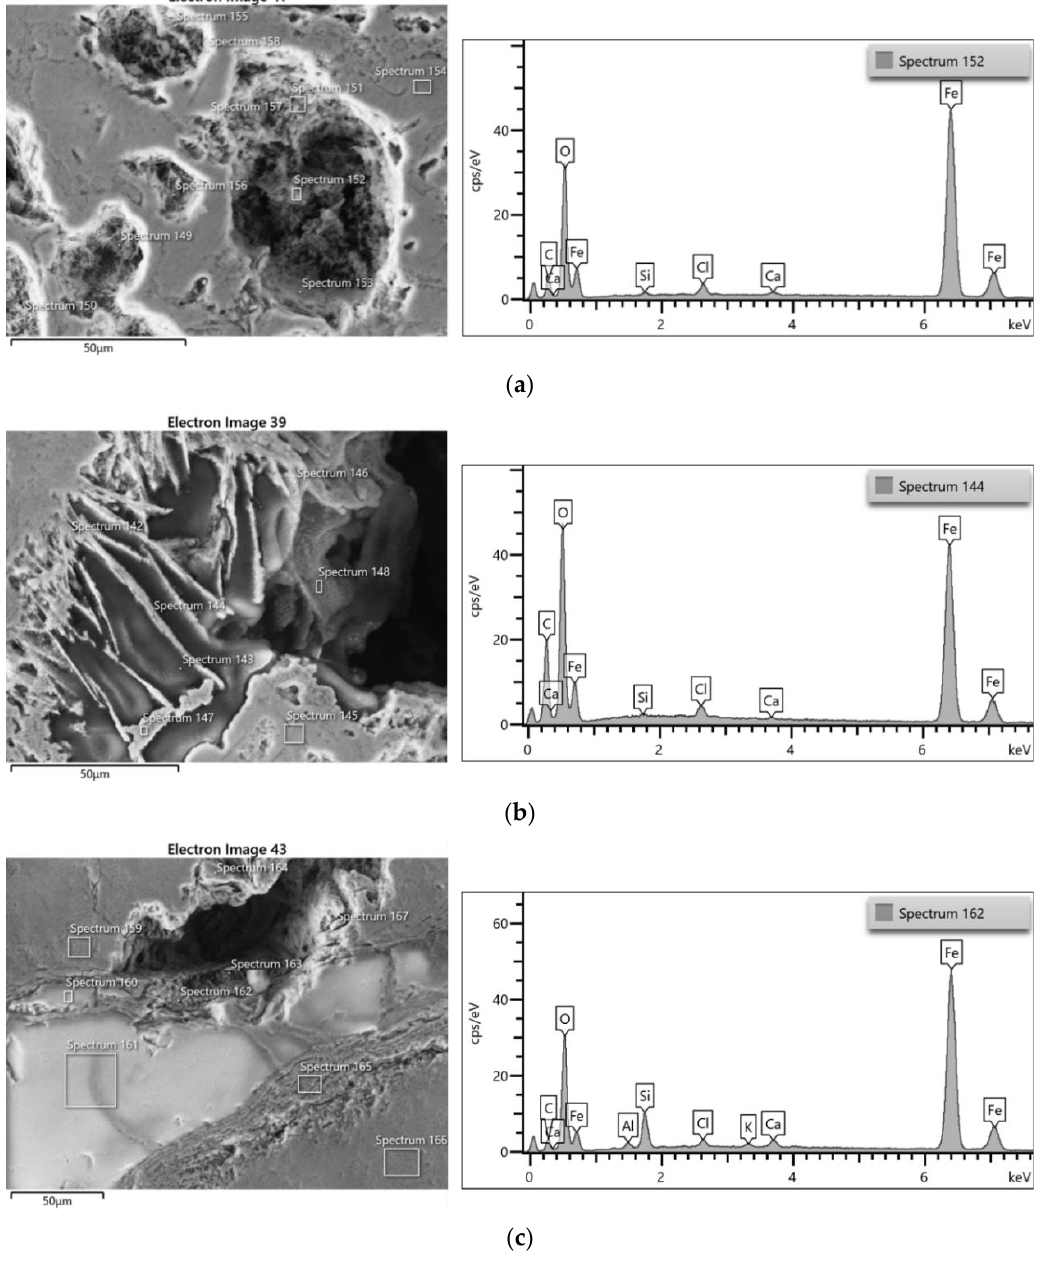
Figure 7. SEM images and EDS spectra of the sample 8: ( a – c ) detailed spectra for each area selected.